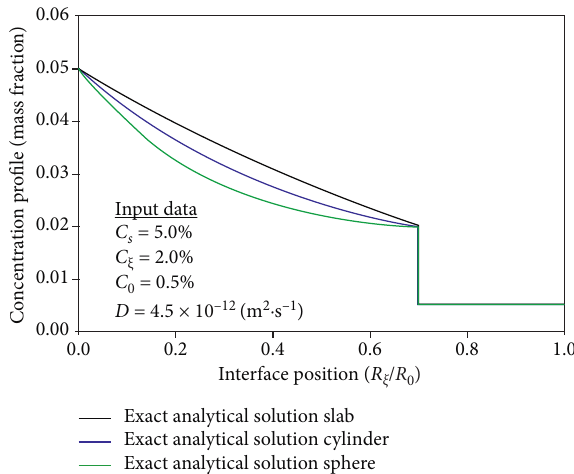
) at 30% of R / R . ξ 0 0